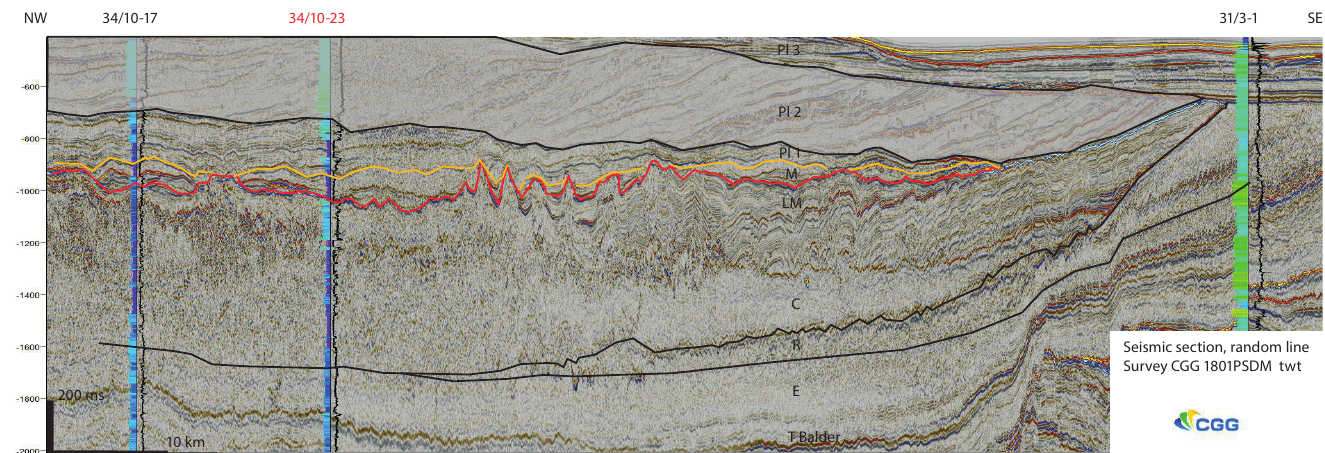
Figure 35. Seismic section (random line) trending NW–SE from the Tampen Spur to Troll area across the Viking Graben, northern North Sea. Gamma logs are shown in Oligocene and younger sections in wells 34/10–17, 34/10–23 (not investigated) and 31/3–1. The Chattian is composed of alternating sand and shale in the west and shales rich in biogenic material in the east. The pattern of reflections is different in the west and the east because sand layers are mobilized and disturbed, while the shales have sets of parallel reflections which are offset by polygonal faults. Deformational features are pronounced in the central part of the section, where the sand is pinching out. The lower Miocene is mainly shaley, while the upper Miocene, between the orange and red horizons have a significant amount of sand occurring in lens-shaped structures attributed to differential compaction. Pleistocene sequence 1 consists of sands and clays mainly derived from the Snotra Formation and includes the Tampen Spur Member which is defined for the Snorre Field but has a larger distribution. It may interfinger with the basal parts of the clinoforms of Pleistocene sequence 2, which is prograding from the east. Pleistocene sequence 3 lies above the URU. PL 3 – Pleistocene above unconformity, PL 2 – Pleistocene with clinoforms, PL 1 – Pleistocene lowest level, M – Middle and upper Miocene, LM – Lower Miocene, C – Chattian, R – Rupelian, E – Eocene, T Balder – Top Balder. See Figs. 2, 5 & 6 for location of the